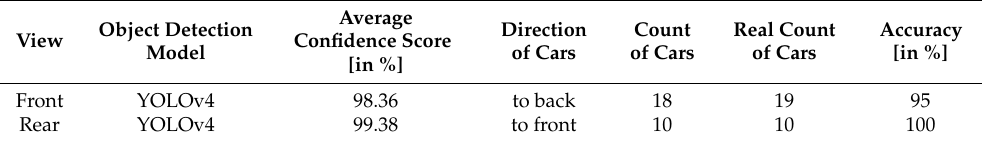
Table 6. Specific information of Sample scenario #2.